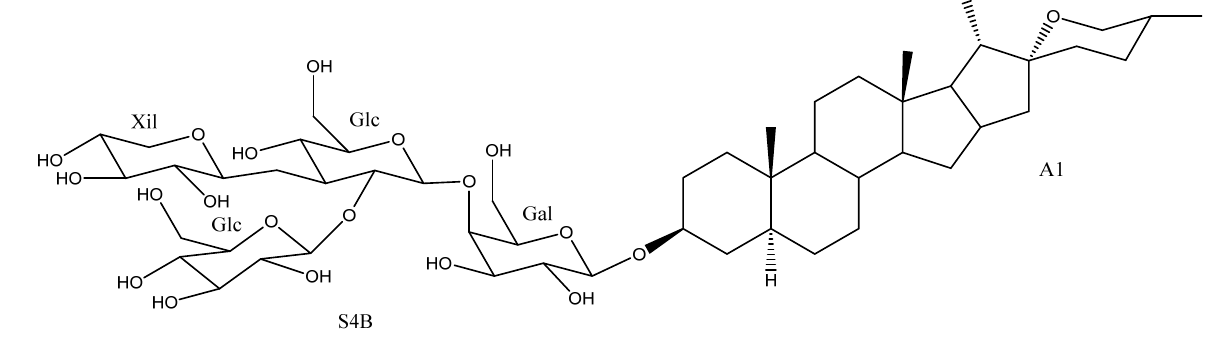
Figure 10. Degalactotigonin ( 2 ).